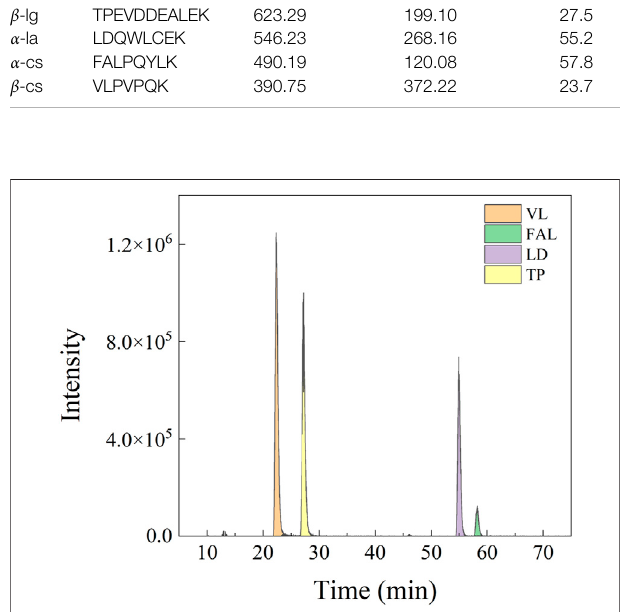
FIGURE 2 | Quantitative ion peak shape of four peptides.